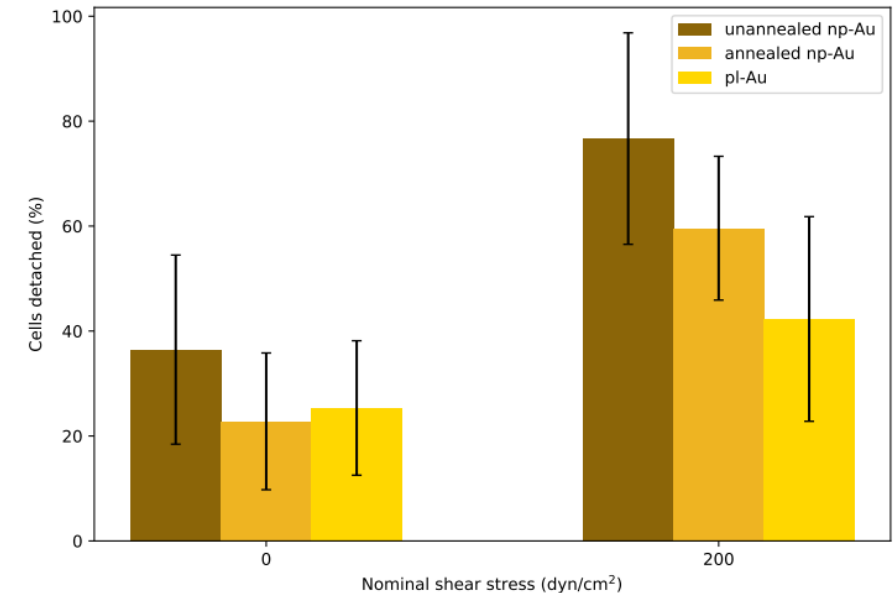
Figure 3. Detachment results for batch experiments. Two min of hydrodynamic shear flow detached cells seeded in the channels for 6 h. The no-shear control group at 0 dyne/cm 2 was only gently washed with phosphate buffered saline (PBS) before fixation. Percent detachments are reported as averages ± one standard deviation. Sample sizes (n) for each group, from left to right: 24, 24, 47, 11, 7, 28 coating patterns.